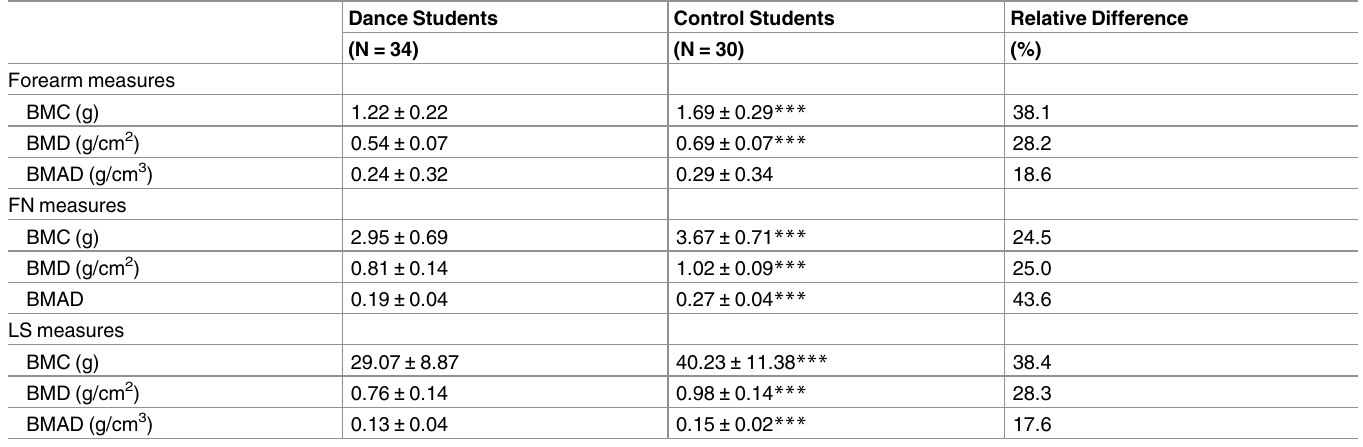
Table 3. Unadjusted bone